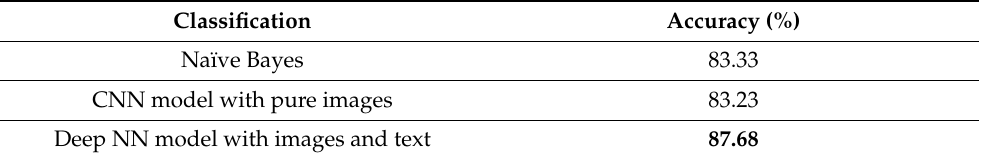
Table 2. Accuracy of